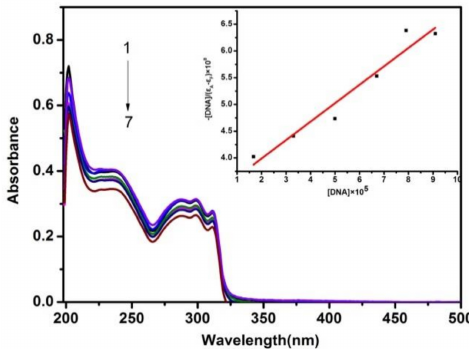
Figure 2. The UV–vis absorption spectra of complex 1 (10 µ M) in the absence and presence of CT-DNA. [DNA] = 0, 15, 33, 55, 100 µ M. Arrows show the decrease in absorbance as the increase of DNA